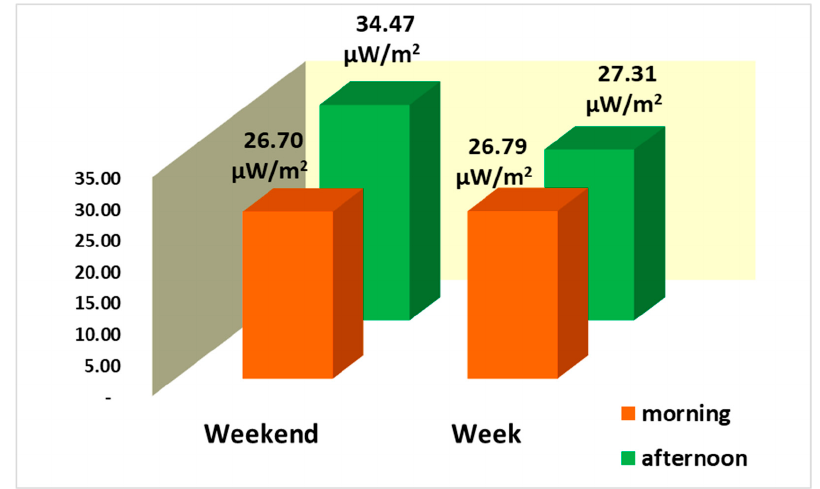
Figure 5. Total average intensity to RF-EMF from the Wi-Fi band, on the week and weekend ( μ W/m 2 ).